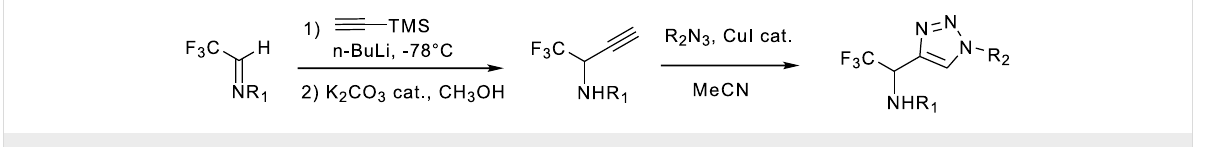
Scheme 1: Synthetic approach to the trifluoromethyl triazoles.